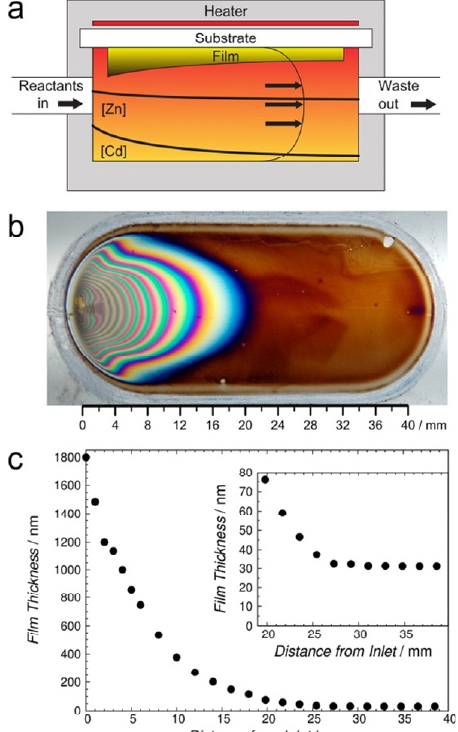
Figure 22. ( a ) Plug flow reactor model showing the Zn and Cd bath concentration as a function of the position (thick lines), the laminar flow profile (thin line) and the temperature profile (color gradation indicates a change from 70 to ~60 °C) in the continuous flow microreactor; ( b ) CdZnS deposition on a Si wafer showing the interference pattern arising from the spatial variation in the film thickness; ( c ) The CdZnS film thickness as a function of the distance from the inlet. Reproduced from